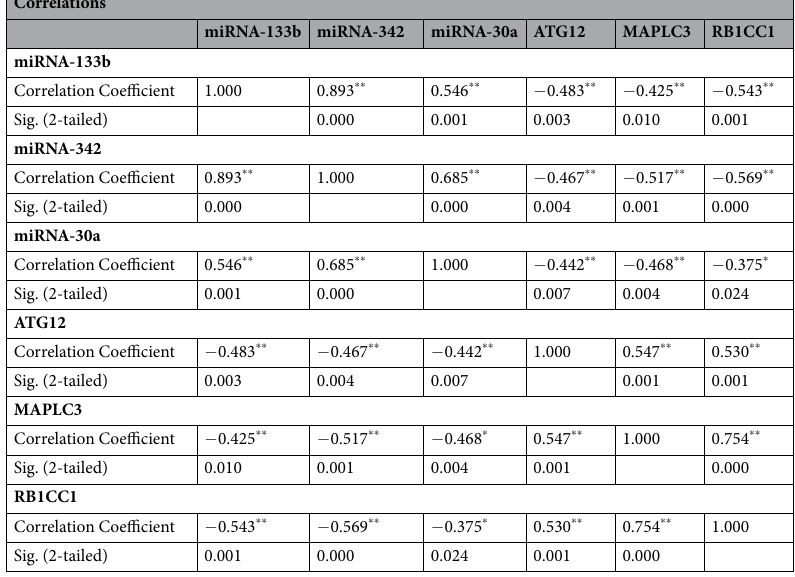
Table 4. Correlation between the selected miRNAs and autophagy transcript among the investigated groups of rats. ** Correlation is significant at the 0.01 level (2-tailed). * Correlation is significant at the 0.05 level (2-tailed). *** Indicates P < 0.001, Unpaired, two tailed t test, N = 8/group. r:Spearman correlation